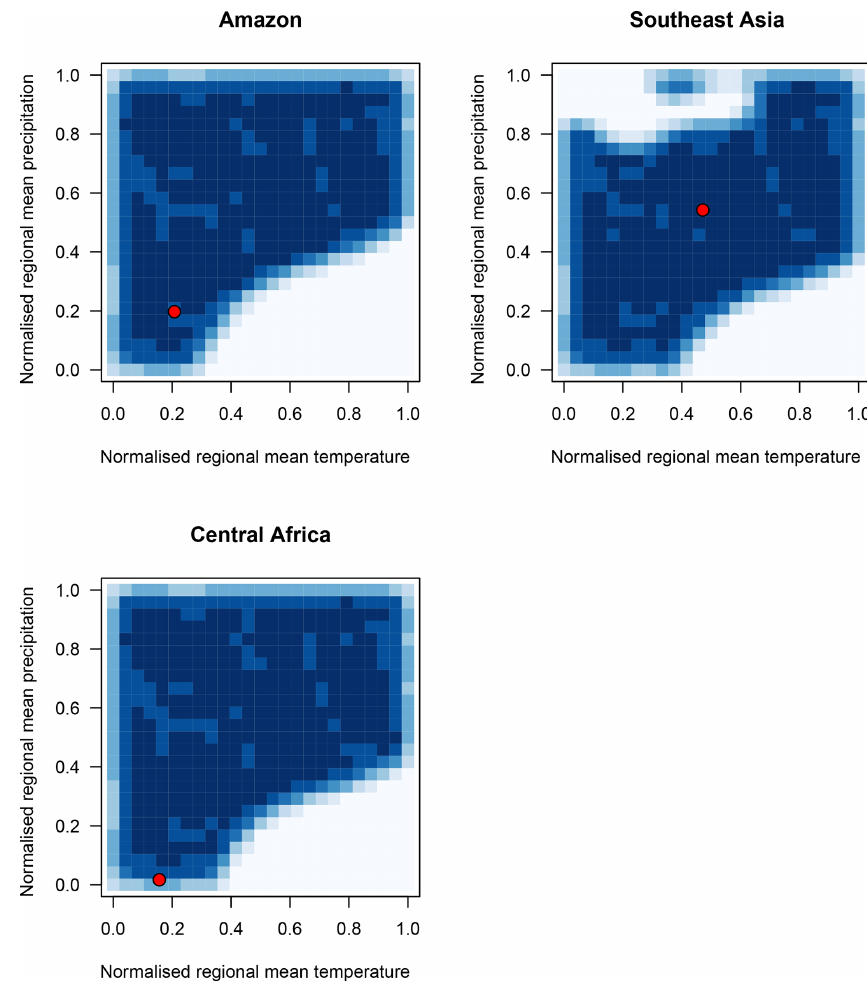
Figure 17. Density of NROY emulated temperature and precipitation pairs for each observed tropical forest fraction, when input parameters are held at their default values. Observed climates for each forest are marked in